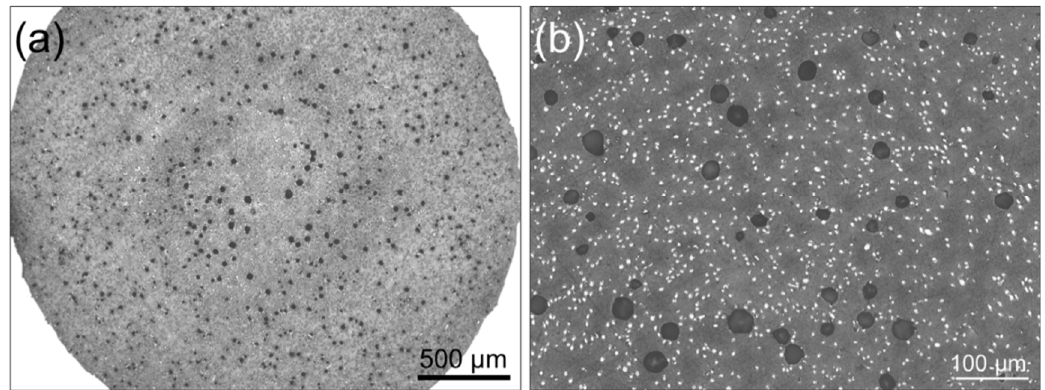
Figure 15. ( a ) Cross section of the filament as received. ( b ) The same cross section in closer detail, where white dots represent carbon fibers and darker regions represent pores that originated in the filament fabrication.